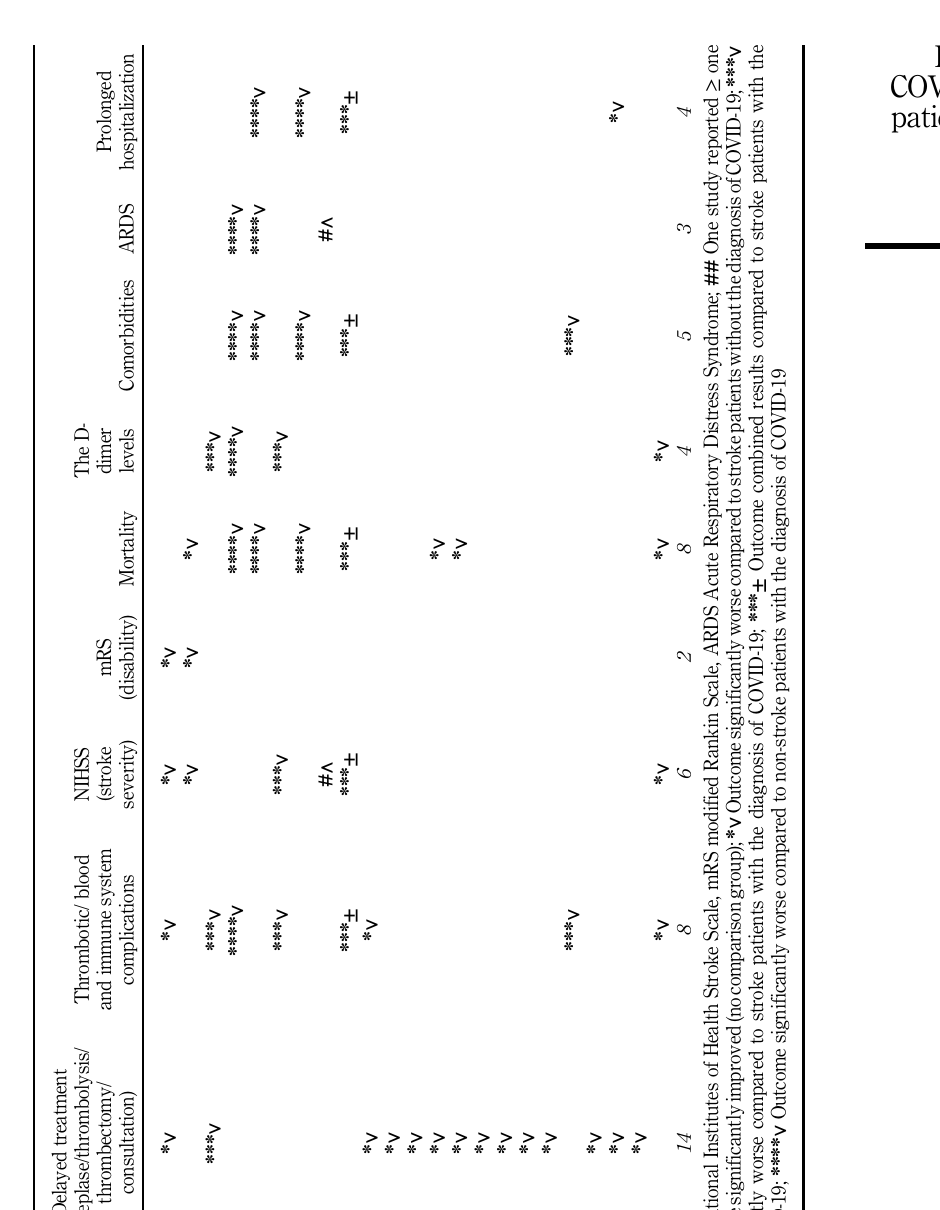
Table 3. The impact of COVID- 19 on patients with